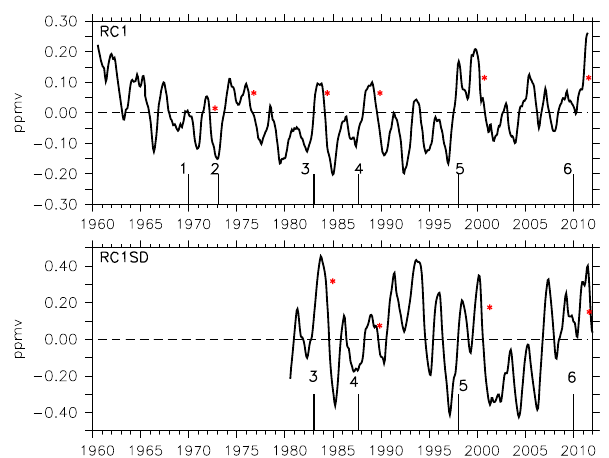
Figure 7. Moisture anomalies in ppmv (detrended, deseasonalized, 12-months running mean) derived from RC1SD and RC1 simula- tions at 80hPa. Black vertical lines mark strong El Niño events (see Fig. 8) and red asterisks mark the respective subsequent wa- ter vapour drop.